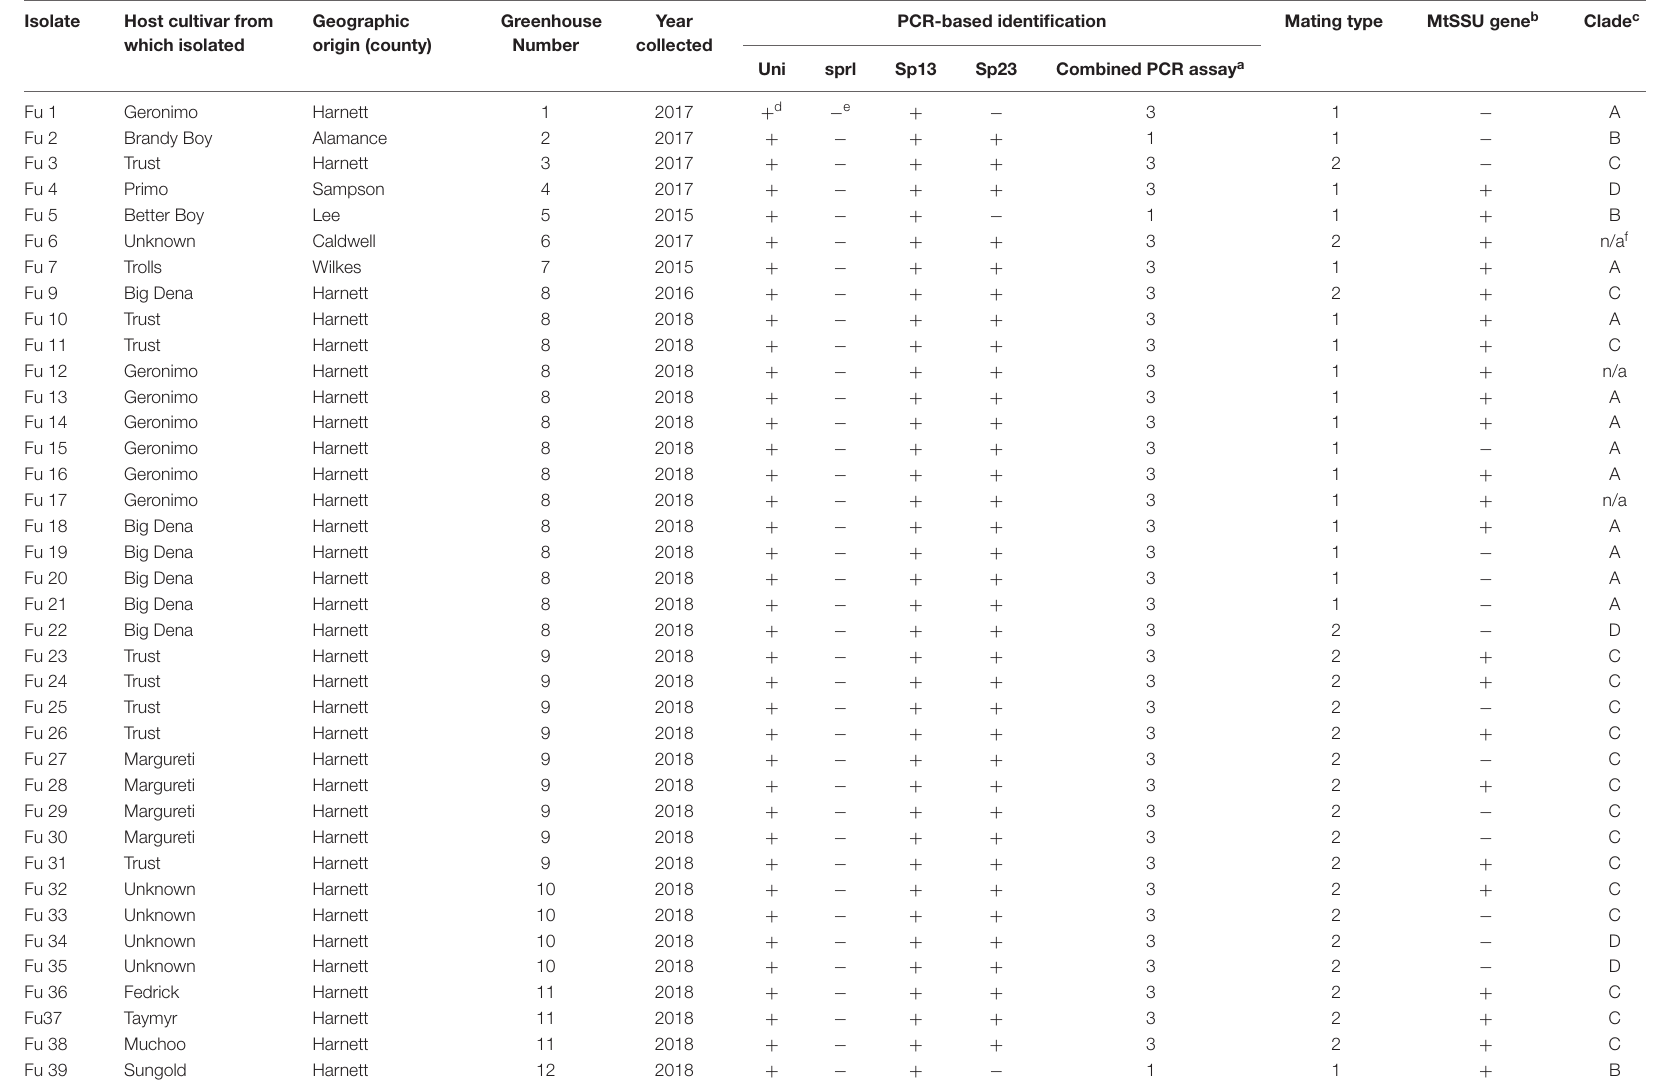
TABLE 1 | Descriptions of the 38 isolates of Fusarium oxysporum f. sp. lycopersici collected from greenhouse tomato in North Carolina and used in this study.